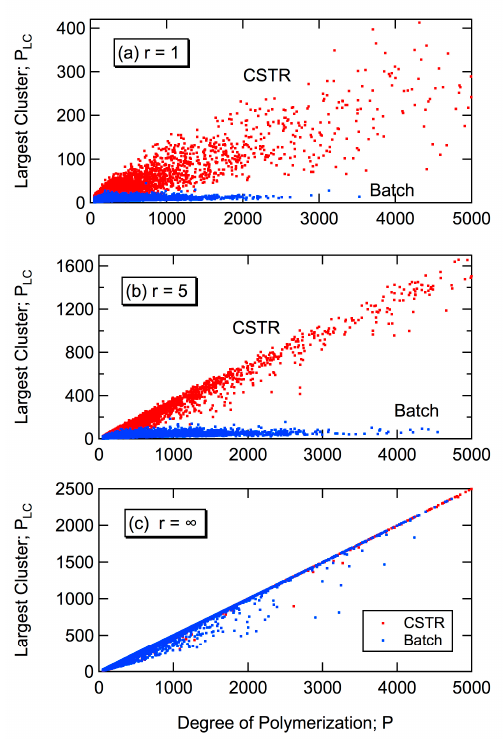
Figure 6. Relationship between the number P LC of units belonging to the largest cluster and the degree of polymerization P . (a) r = 1; ξ = 0.5 for CSTR, and x A = 0.95 for batch. (b) r = 5; ξ = 0.306 for CSTR, and x A = 0.95 for batch. (c) r = ∞ ; ξ = 0.25 for CSTR, and x A = 0.95 for batch.